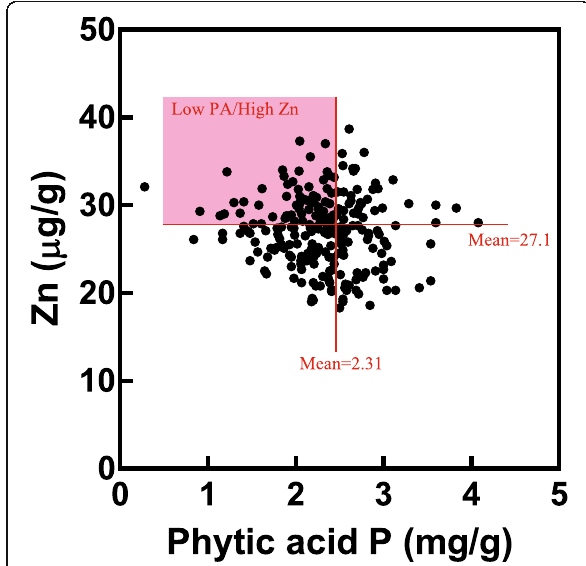
Fig. 4 Relationship between PA-P and Zn concentrations in rice